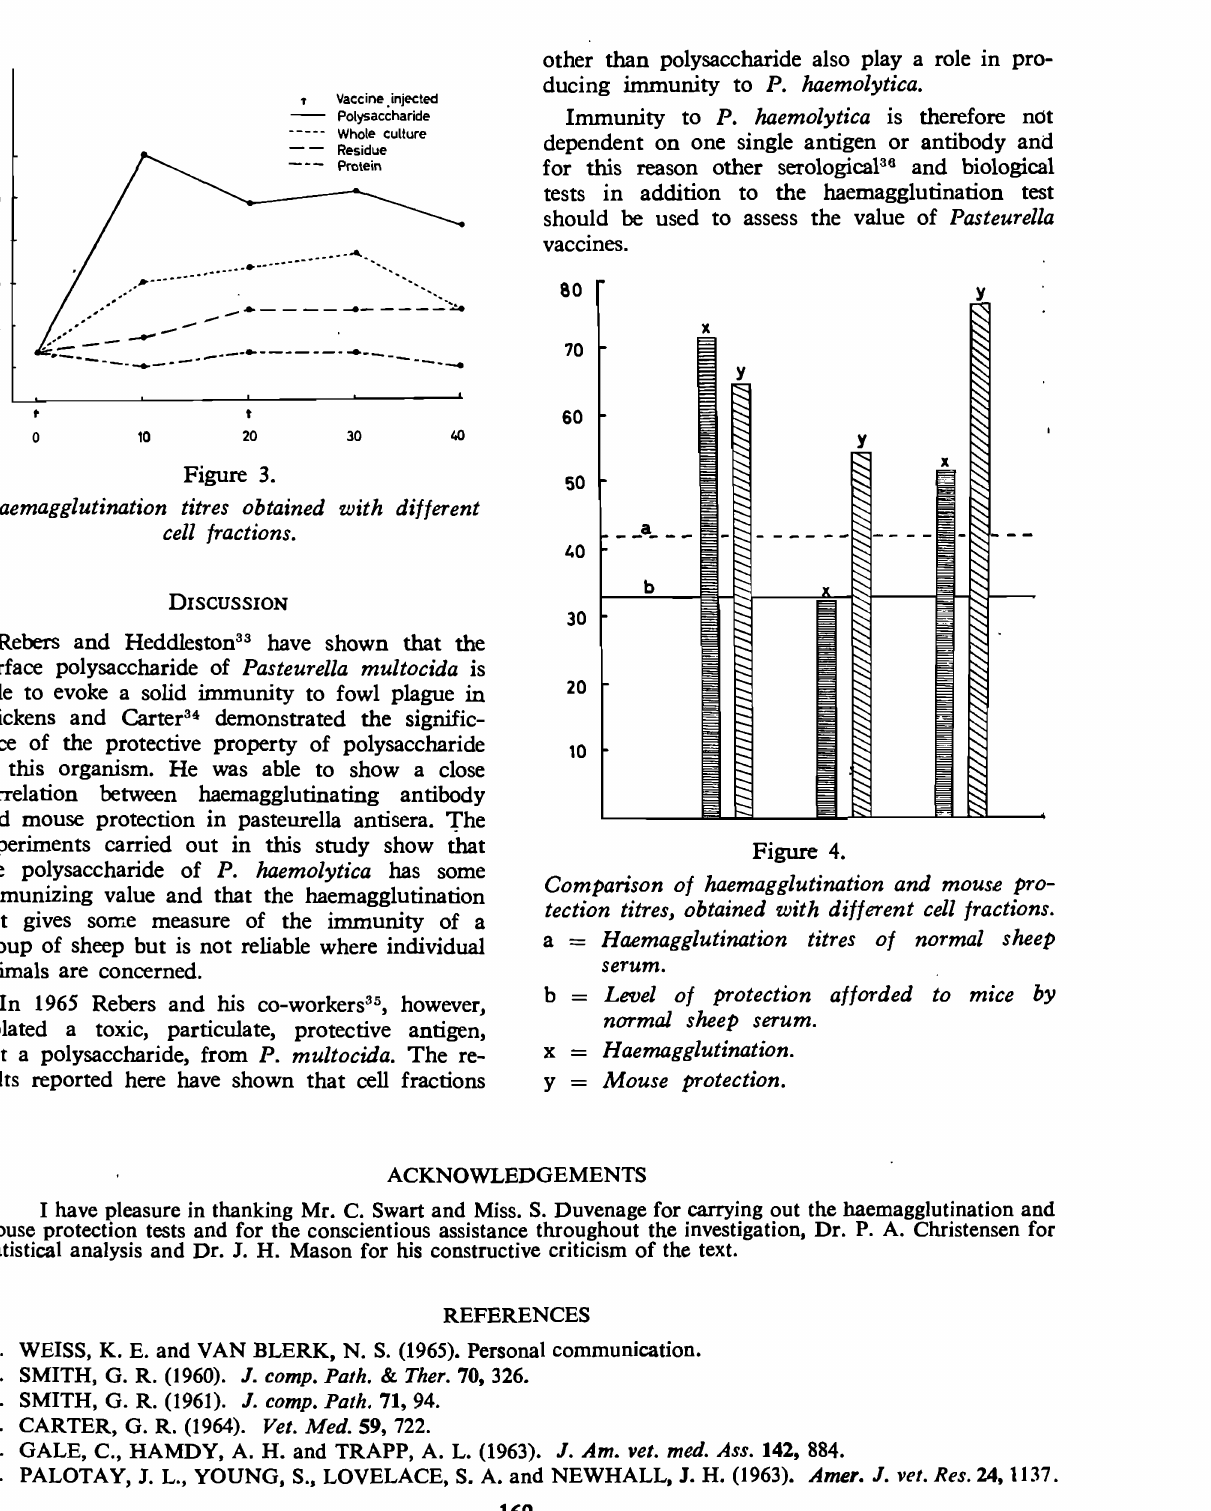
Figure 4. Comparison of haemagglutination and mouse pro tection titres, obtained with different cell fractions. a = Haemagglutination titres of normal sheep serum. b Level of protection afforded to mice by normal sheep serum. x Haemagglutination. y Mouse